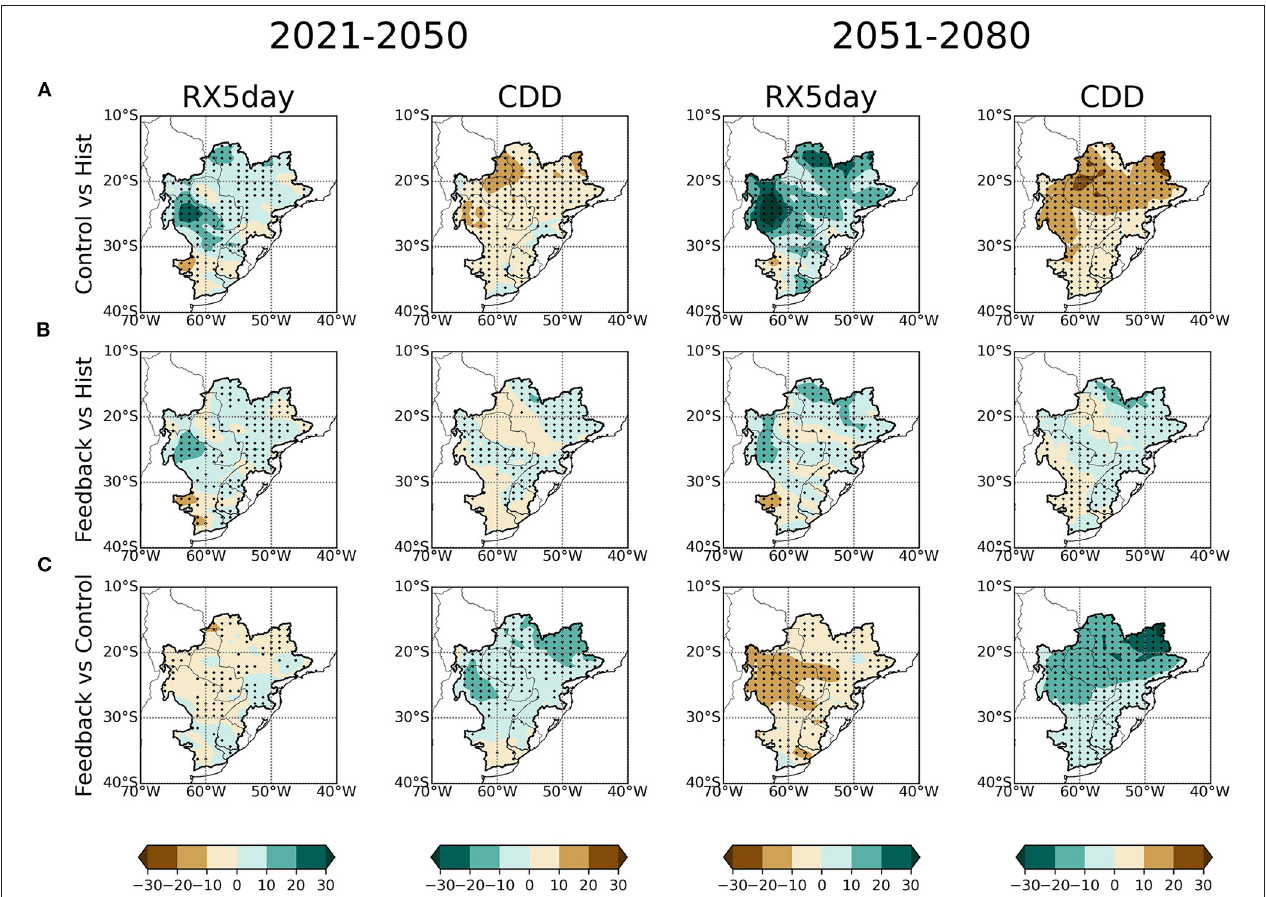
FIGURE 5 | Annual projected changes in precipitation extreme indices: RX5day (wettest consecutive 5days) (%) and CDD (consecutive dry days) (days) derived from the three-member ensemble mean values for two future 30-year periods (2021–2050 and 2051–2080) and the mean values over the historical period (1980–2010) considering (A) projected changes under the RCP8.5 emission scenario (control simulations) relative to historical, (B) projected changes for the geoengineering simulations combined with the RCP8.5 pathway (feedback simulations) relative to historical, and (C) the difference between (A,B) . Stippling indicates robust changes according to the definition of robustness adopted in this study [see section projections in the text for further